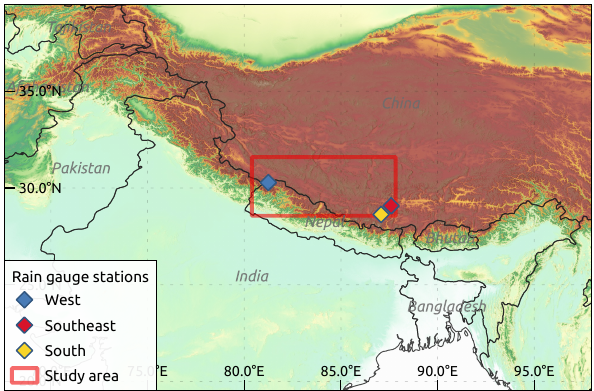
Figure 1. Overview of the study area and the 3 rain gauge stations located within the boundaries of the